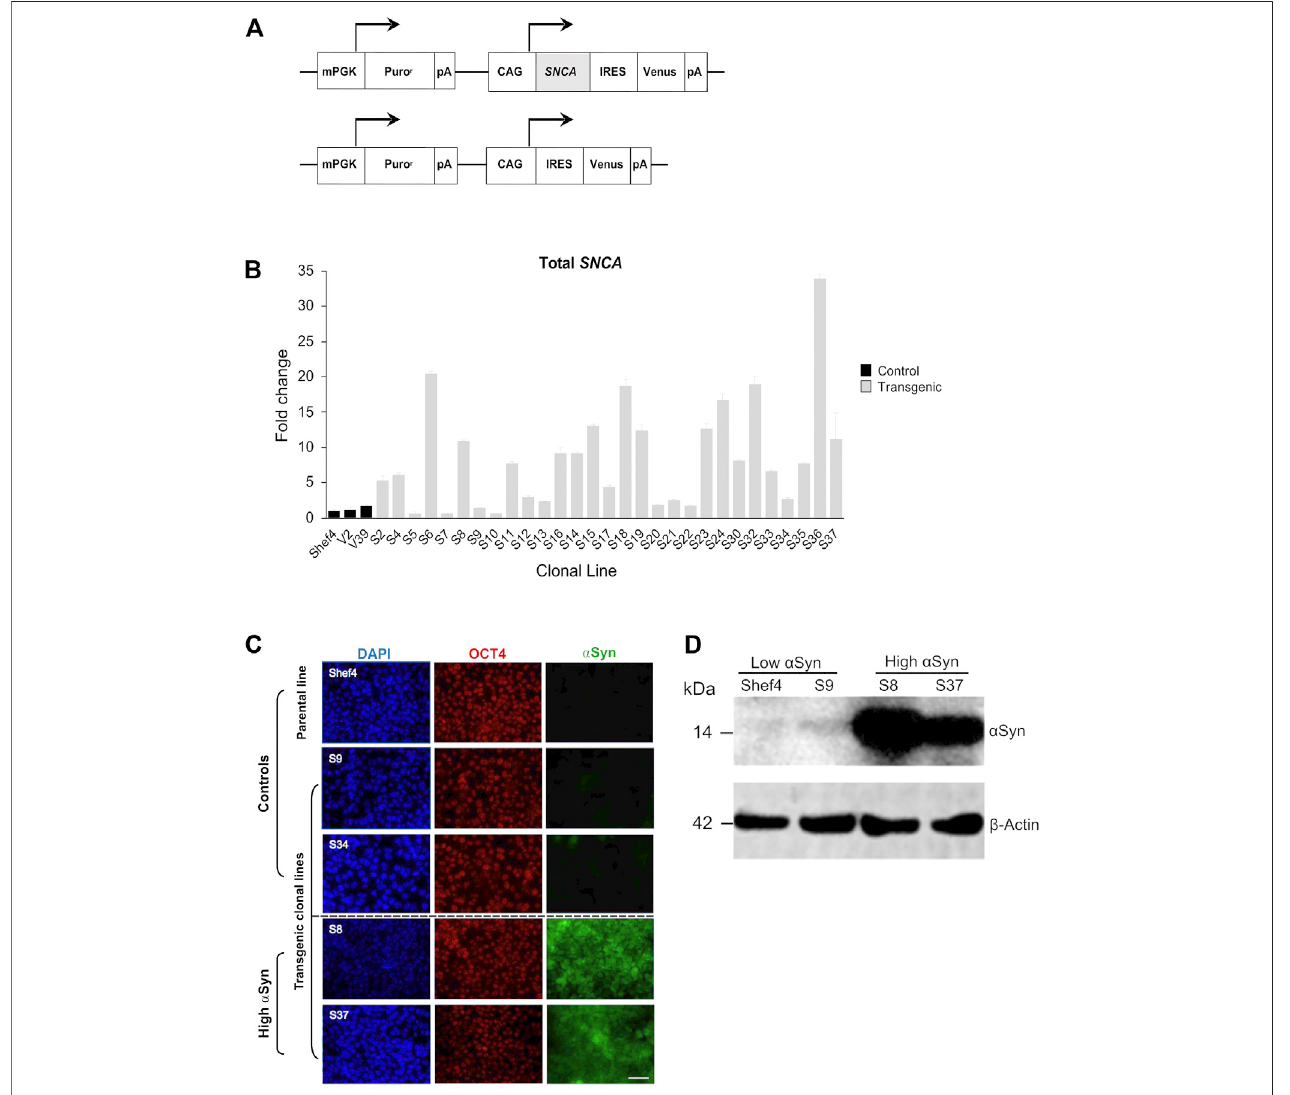
FIGURE1| EstablishmentofclonalhESClinesover-expressing ⍺ Syn. (A) SchematicofpCAG-SNCA-IRES-VenusandpCAG-IRES-Venusconstructstransfected intoShef4hESCstogenerateclonallines. (B) QuantitativeRT-PCRmeasuringtotal SNCA expression(mRNA)levelsinmultipleself-renewingundifferentiatedtransgenic clones generated from parental Shef4 hESC lines. Data was normalised to 18S rRNA levels, and shown relative to expression in the parental hESC Shef4 line. Each bar represents the mean and standard deviation of three technical replicates. (C) Representative immunocytochemistry images of undifferentiated hESC clones derived from the parental cell lineShef4, and transgenic clonal lines S9, S34, S8, and S37, stained for DAPI (blue), OCT4 (red), and α Syn (green). Scale bar = 50 µm. (D) Western blot for total α Syn and ß -actin in undifferentiated clonal lines for Shef4 and S9 (low α Syn), and S8 and S37 (high α Syn) clones.